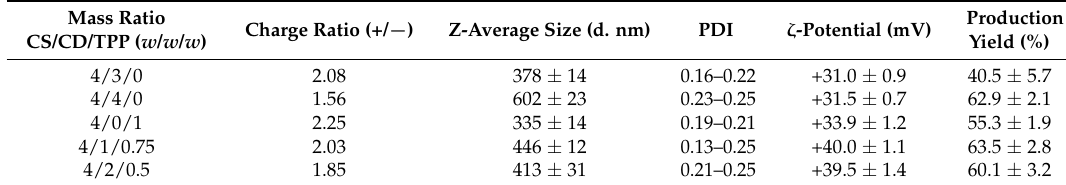
Table 3. Physicochemical properties of CS 70/5 /SBE β CD/TPP quercetin-loaded nanoparticles (mean ± S.D., n = 3).